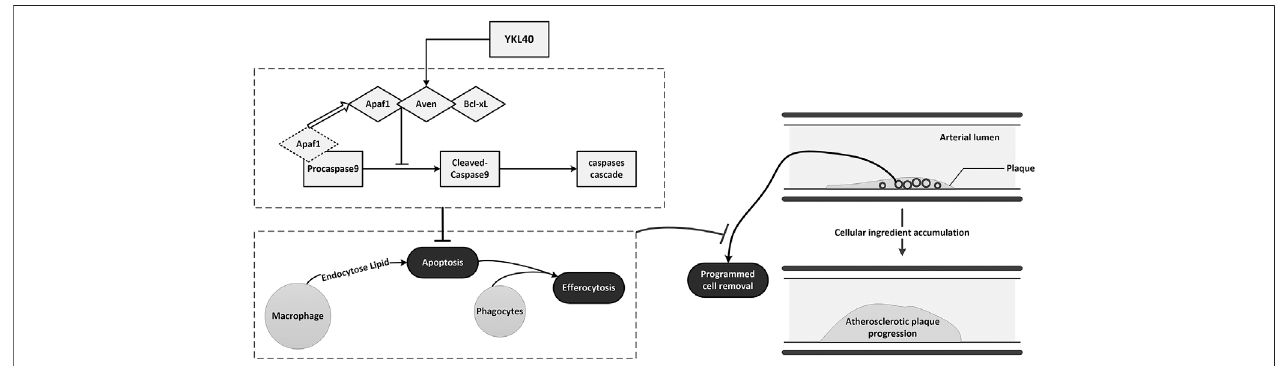
FIGURE 8 | Schematic diagram of the mechanism of YKL-40 aggravates early-stage atherosclerosis by inhibiting macrophage apoptosis in an Aven- dependent way.